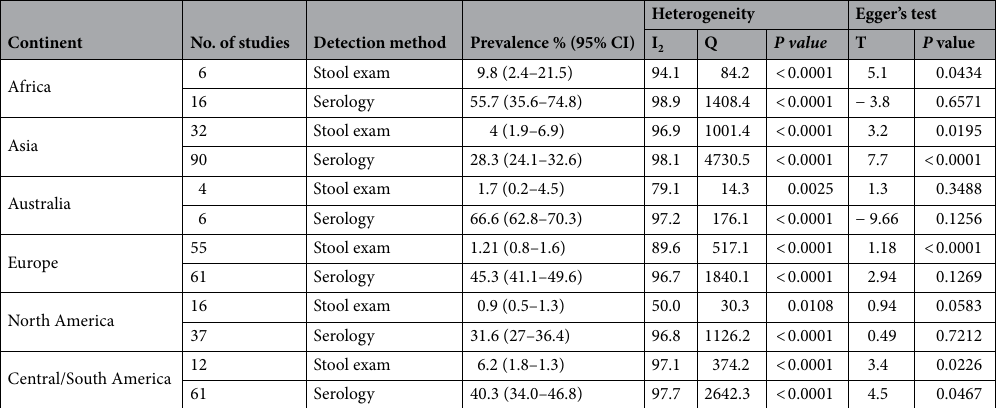
Table 1. Pooled prevalence of Toxoplasma infection in domestic cats and subgroup